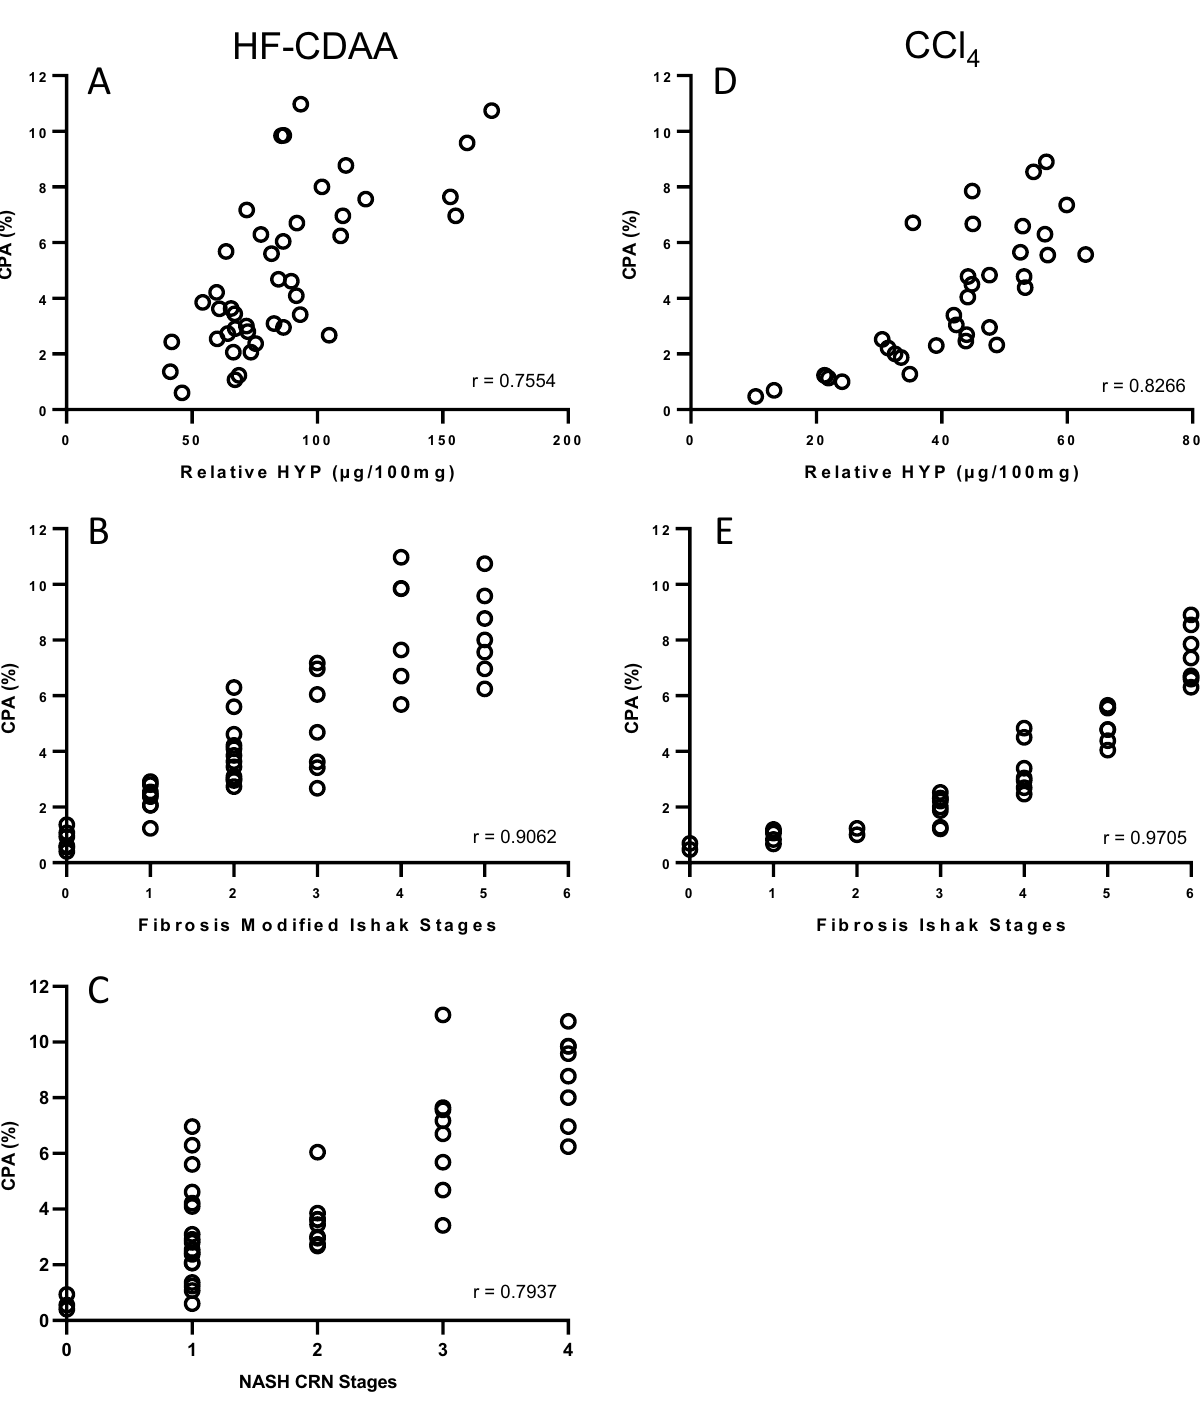
Figure 3. Correlation of CPA values with relative HYP content and fibrosis scores in HF-CDAA and CCl4 mouse models. The agreement of CPA values with those obtained with HYP content ( A and D ), fibrosis modified Ishak ( B ), Ishak ( E ) and NASH CRN ( C ) scores was evaluated using linear regression analysis. Data correspond to mean values per animal of control (n = 4–6 mice) and CCl 4 - or HF-CDAA-treated mice (6–10 mice/group). r = Spearman correlation coefficient. p value < 0.05 was considered statistically